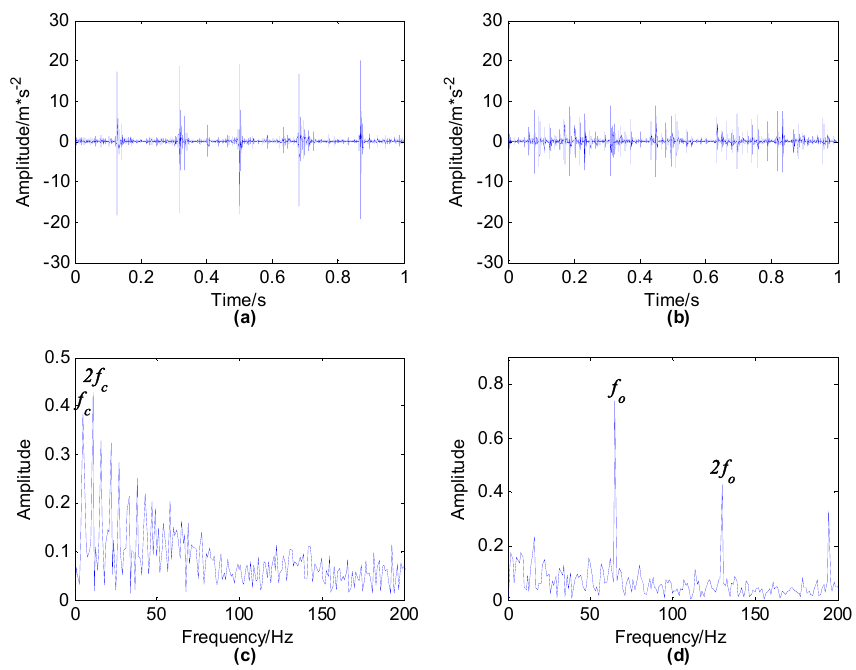
x ; ( b ) source signal x ; ( c ) envelope 1 2